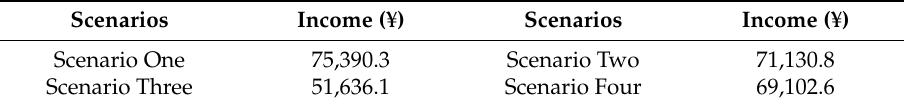
Table 1. The income of the ELAN in different scenarios.